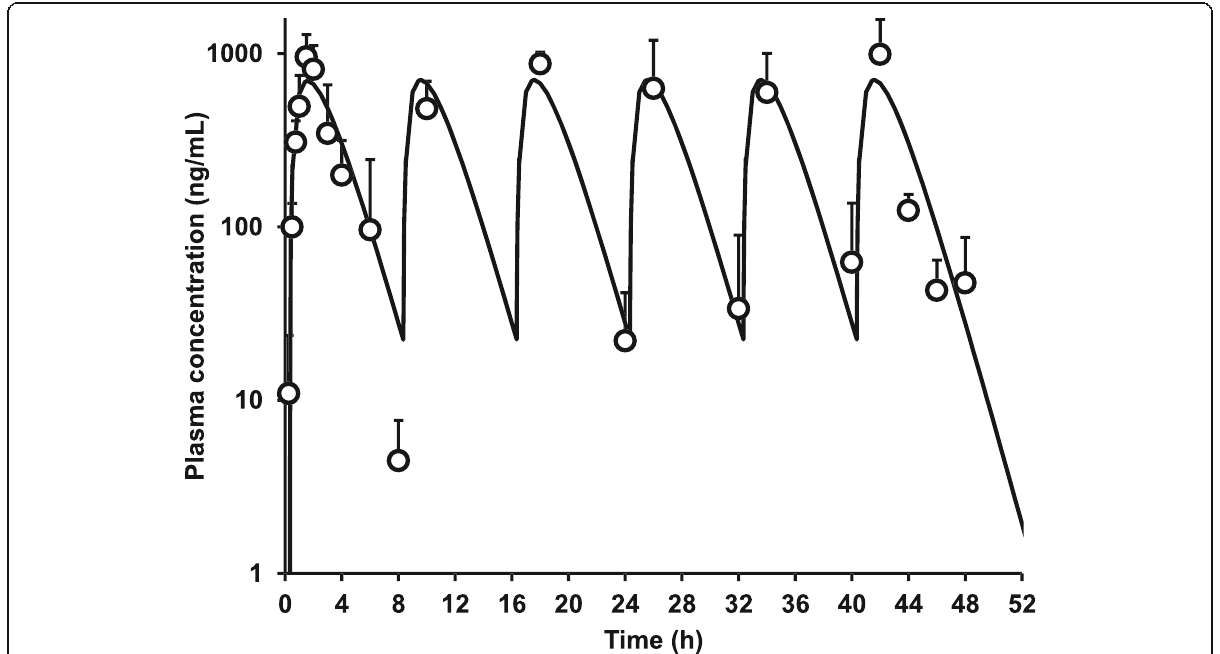
Fig. 4 Effect of multiple oral dosing on plasma concentration-time profile of N-251. A dose of 68 mg/kg of N-251 was orally administered every 8 h in normal-fed mice. Results were expressed as mean with the bar showing the SD value. The solid line was the simulation line calculated utilizing the equation shown in the “ Methods ” section as obtained in the fitting study for plasma concentration profile after a single oral